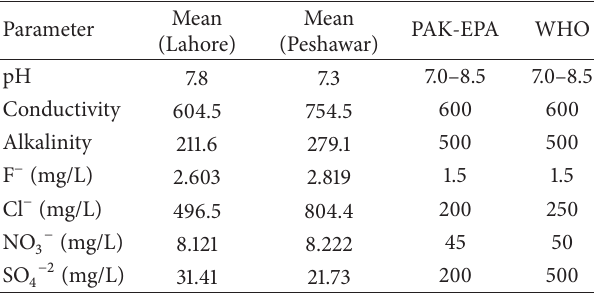
Table 4: Comparison of mean levels with WHO